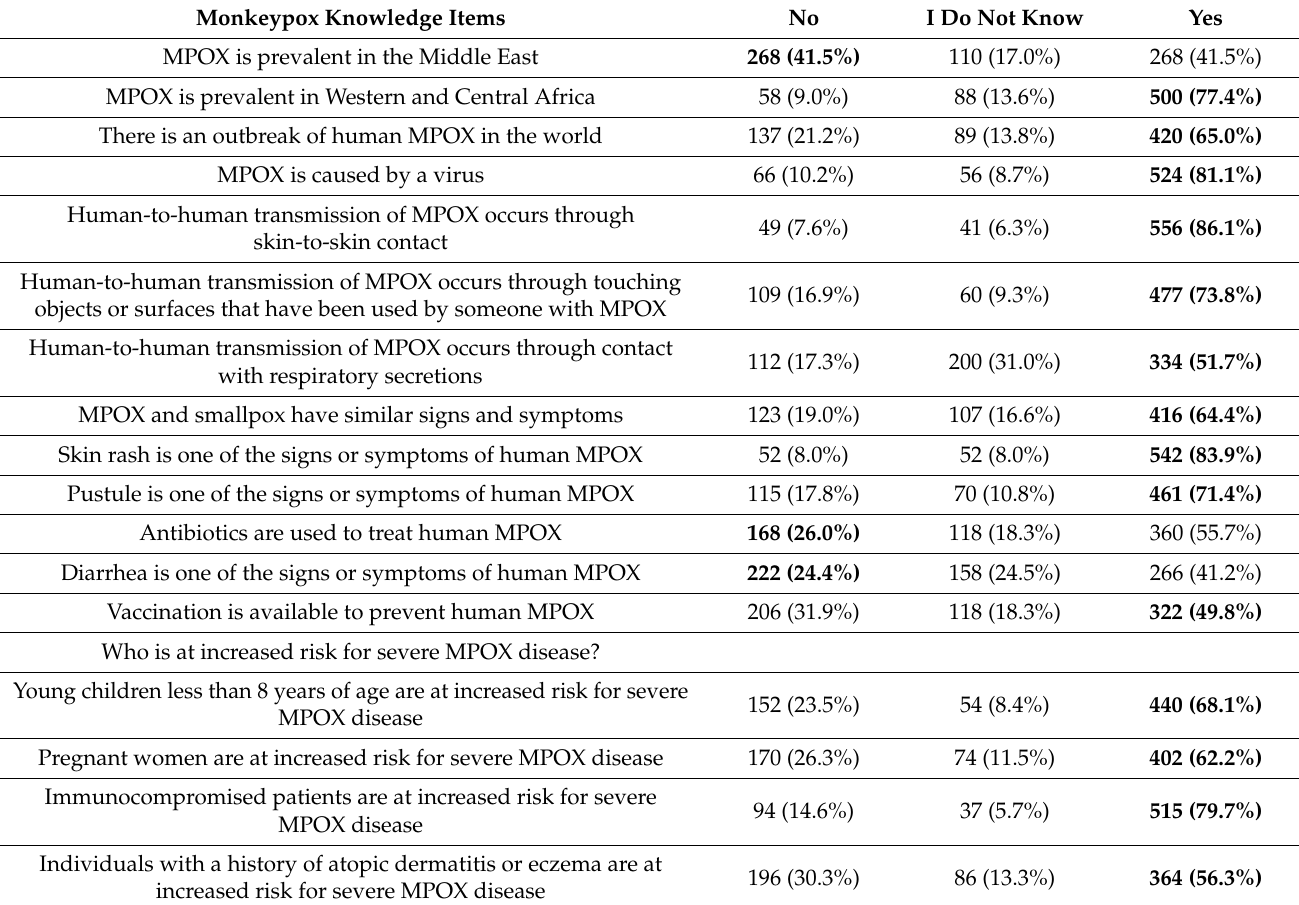
Table 2. Description of the knowledge scale items’ responses.